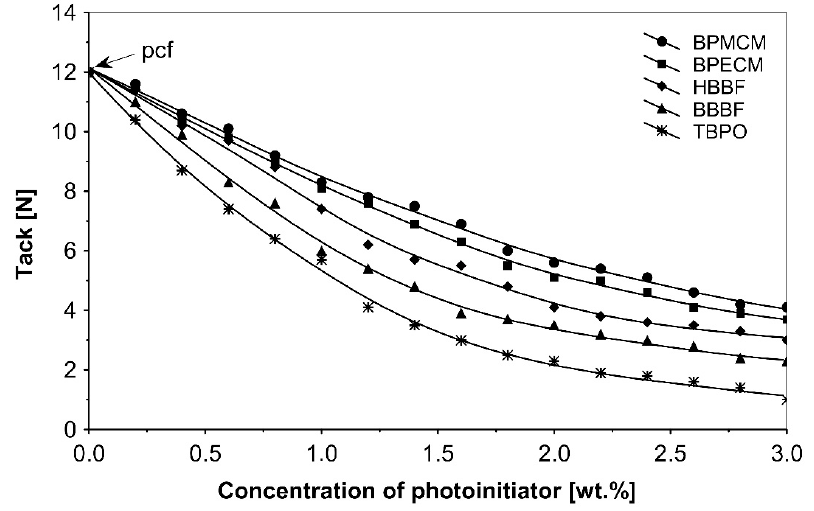
Figure 2. Influence of multifunctional photoinitiators on the tack of a UV ‐ crosslinked acrylic PSA.